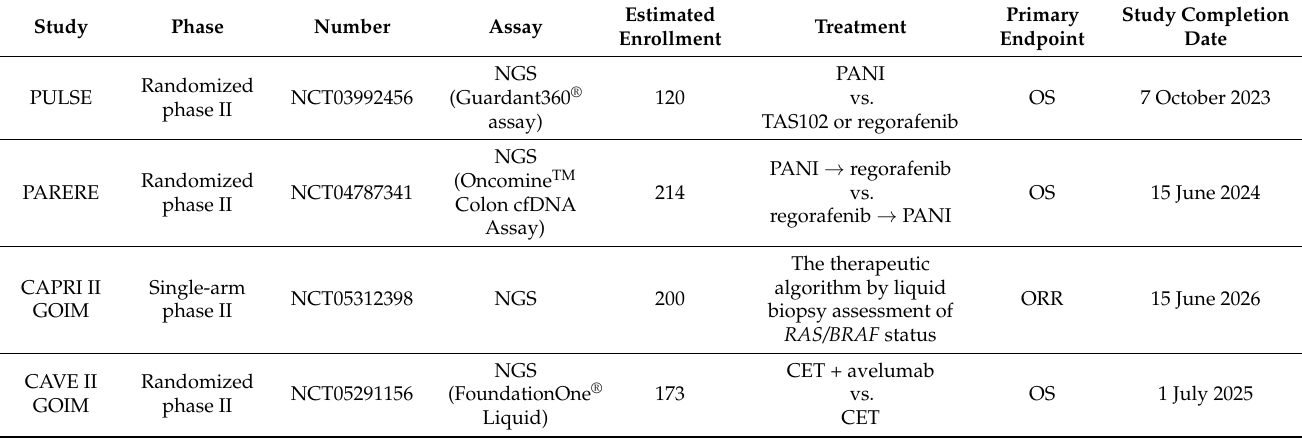
Table 2. Ongoing trials of anti-EGFR monoclonal antibody rechallenge based on liquid